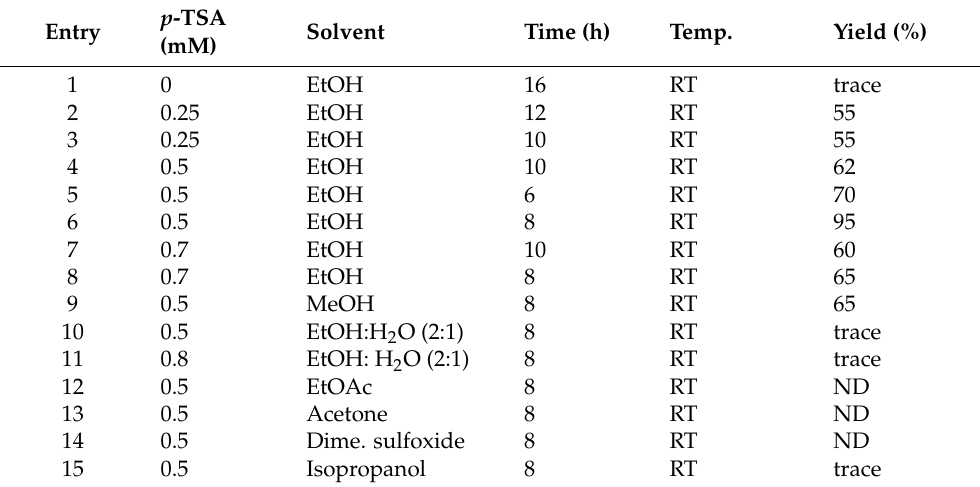
Table 1. Conditions for the reaction optimization.